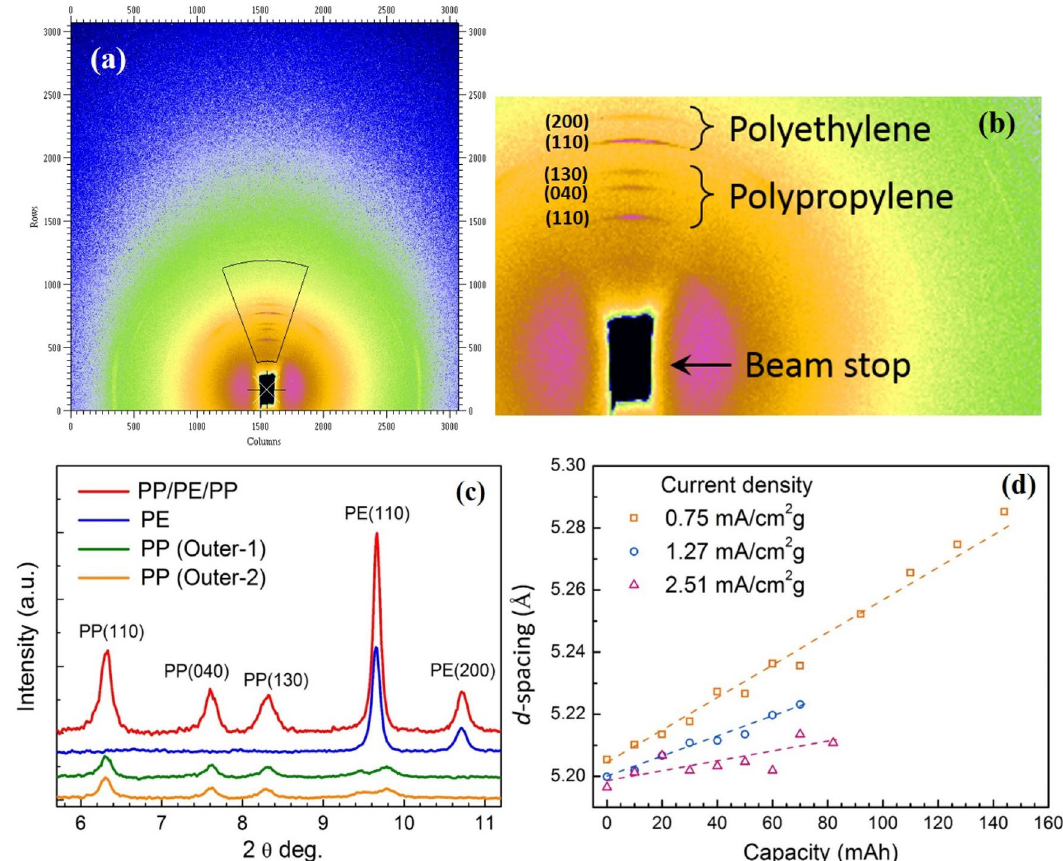
Figure 4. ( a , b ) Two dimensional (2D) XRD image of LIBs, ( c ) XRD of trilayer separator (PP/PE/PP) and its monolayer (PP and PE) and ( d ) the evolution of PP (040) on d -spacing respect to capacity with three different current density of 2.51, 1.27 and 0.75 mA cm −2 g −1 . Data points were linear fitted as the dash